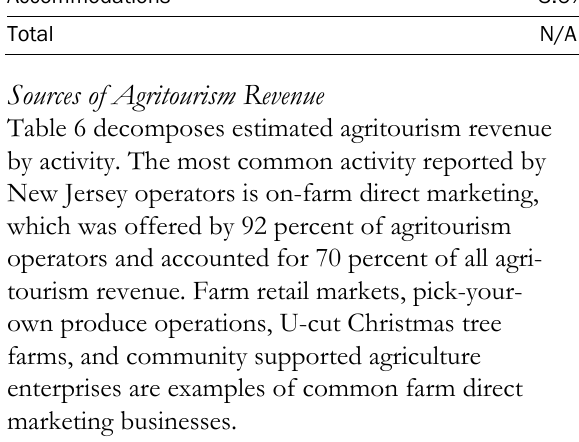
Type of agritourism